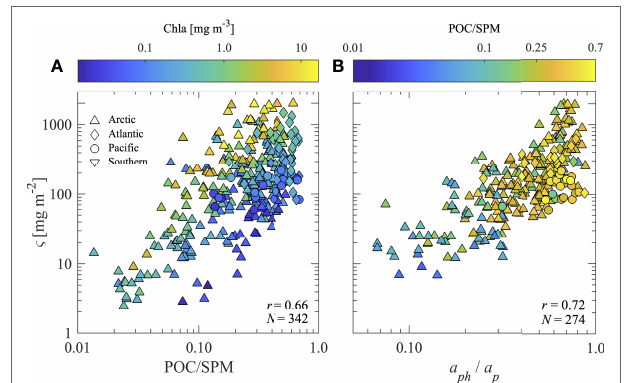
FIGURE 3 | Scatter plots of (A) ς vs. POC/SPM with color indicating value of Chla and (B) ς vs. a ph (410)/ a p (410) with color indicating value of POC/SPM. Composition parameter ς = Chla/ b bp is calculated with b bp at light wavelength λ = 550 nm. The Pearson correlation coefficient r based on log-transformed data and number of samples N are